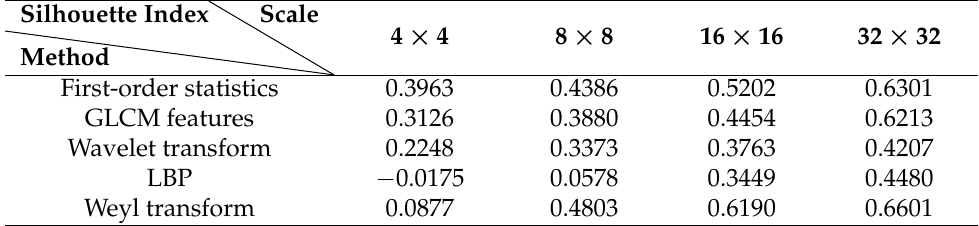
Table 1. Silhouette index of five feature spaces in different spatial scales for four